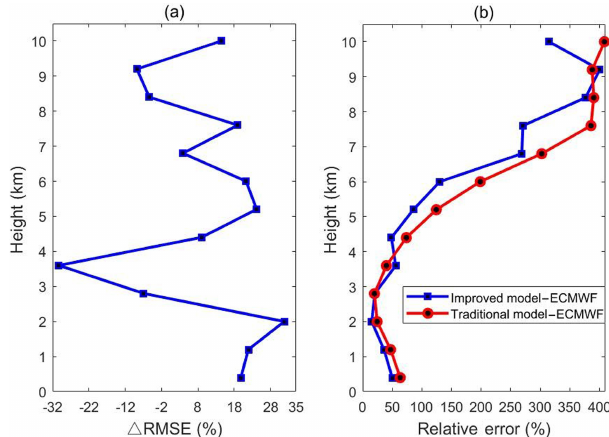
Figure 5. In the scenario of voxels without GNSS-ray penetration (a) the percentage of RMSE improvement and (b) the relative error change with height (the blue curve and red curve are derived from the differences between the profiles of the improved model, the tra- ditional model and ECMWF grid data, respectively, for 64 epochs from 25 March to 25 April